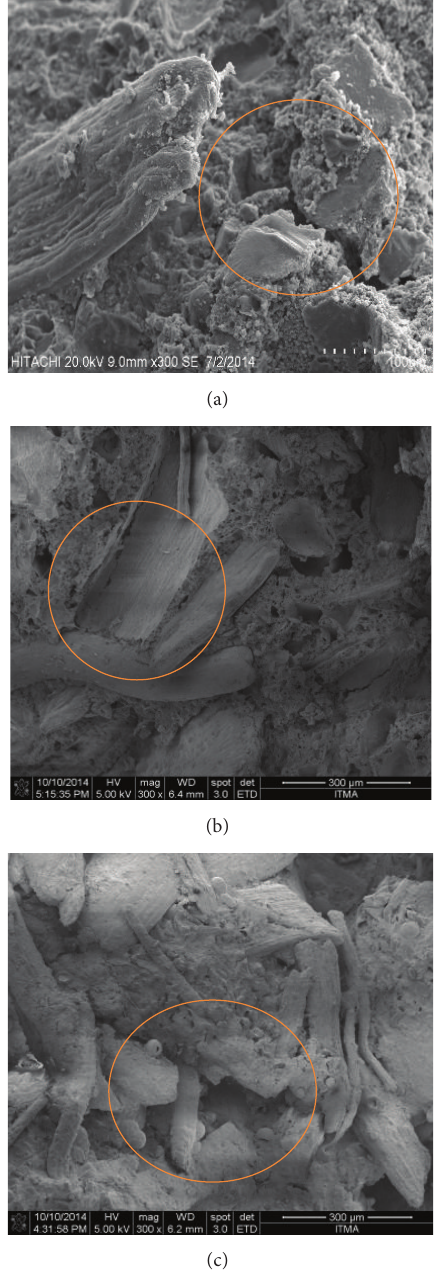
Figure 6: SEM micrographs of the soil burial samples. (a) PHBv/ EFB/NPKC2, 0 weeks, (b) PHBv/EFB/NPKC2, 8 weeks, and (c) PHBv/EFB/NPKC2, 16 weeks. Note: PHBv (poly(hydroxybutyrate- co-valerate)), NPKC2 (coated), and EFB (empty fruit